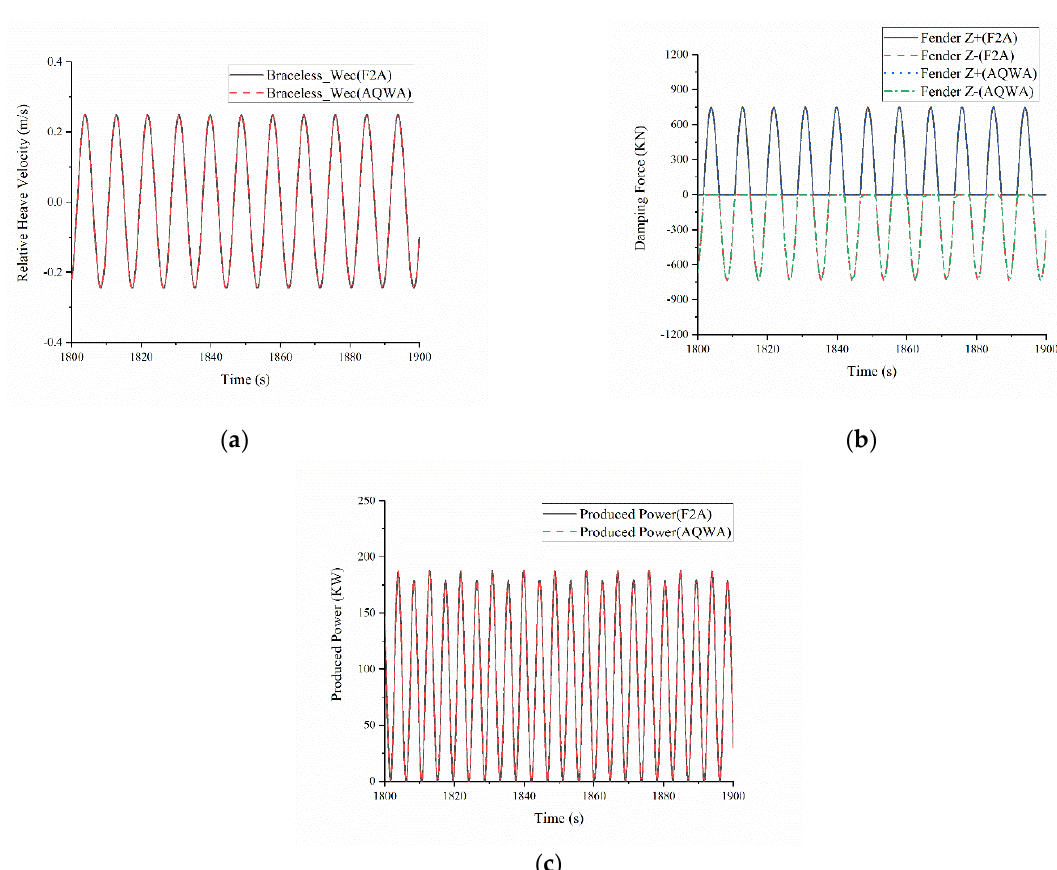
Figure 7. Time series of different responses of the combined structure under regular waves: ( a ) Relative Heave Velocity; ( b ) Damping Force; ( c ) Produced Power.